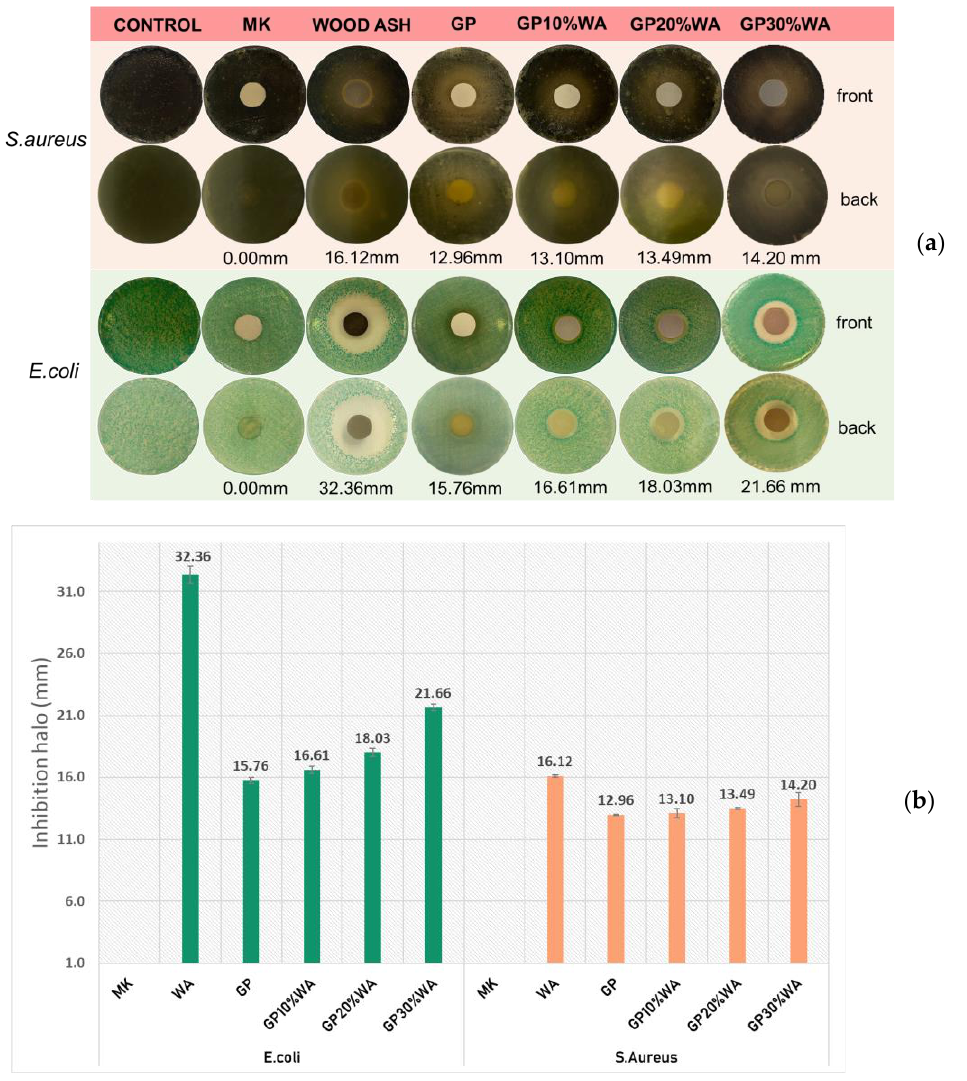
Figure 6. Antibacterial test results: ( a ) Petri plate results; ( b ) Graphical representation of inhibition halos’ measurements.